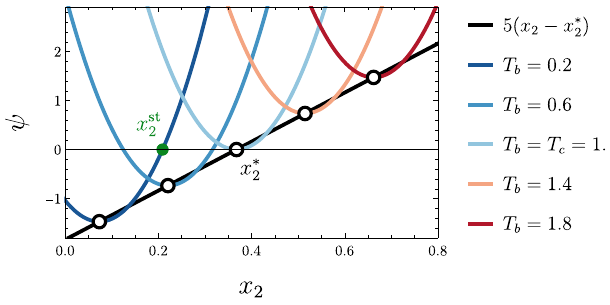
ð 8 Þ Fig. 2 Stability vs. temperature. ψ ( x 2 , T b ), as de fi ned in Eqs. (13), (14)), is a Þ (black) as a function of parabola that slides on the linear line 5 ð x 2 (cid:2) x (cid:3) 2 temperature. The minimum of the parabola coincides with the black line and is denoted by white dots. For T b > T c , ψ is strictly positive; for T b = T c , ψ ¼ x (cid:3) is non-positive only at x , where it zeros; for T b < T c , ψ is both positive 2 2 and negative. The contrast between these positive and negative regions at T b < T c exactly accomplishes the wanted behavior in Fig. 1a, which is encapsulated by Eq. (8). The point x 2 where ψ vanishes corresponds to the stability point x st (such a point is denoted in green in the Fig. for T b = 0.2) 2 that separates between the stable region and the unstable region. It corresponds to the black line in Fig. 1a,